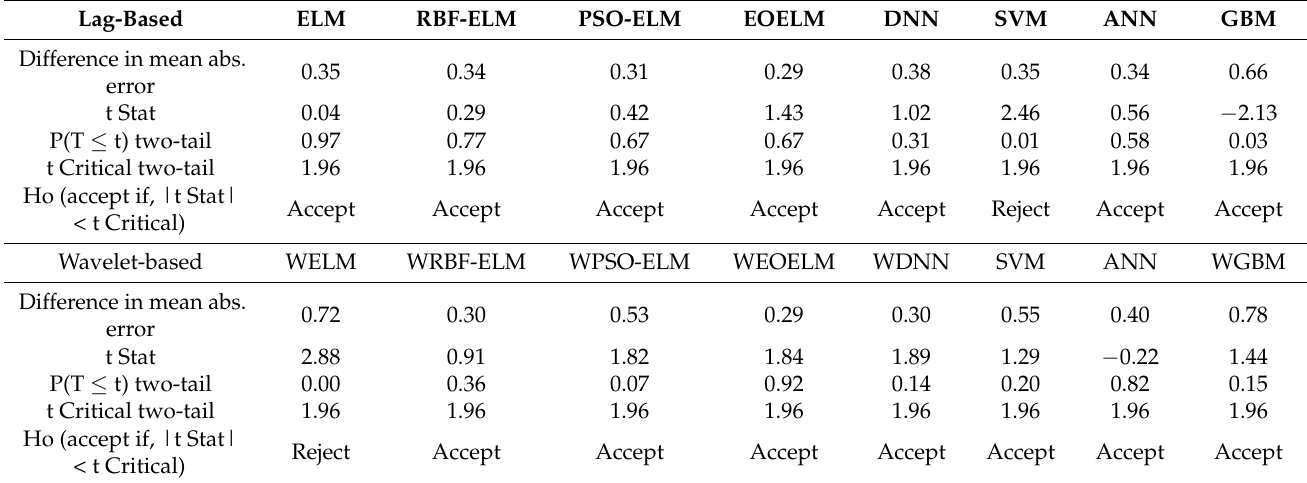
Table 7. Two-tailed t -test for comparing models’ performance for Fal at